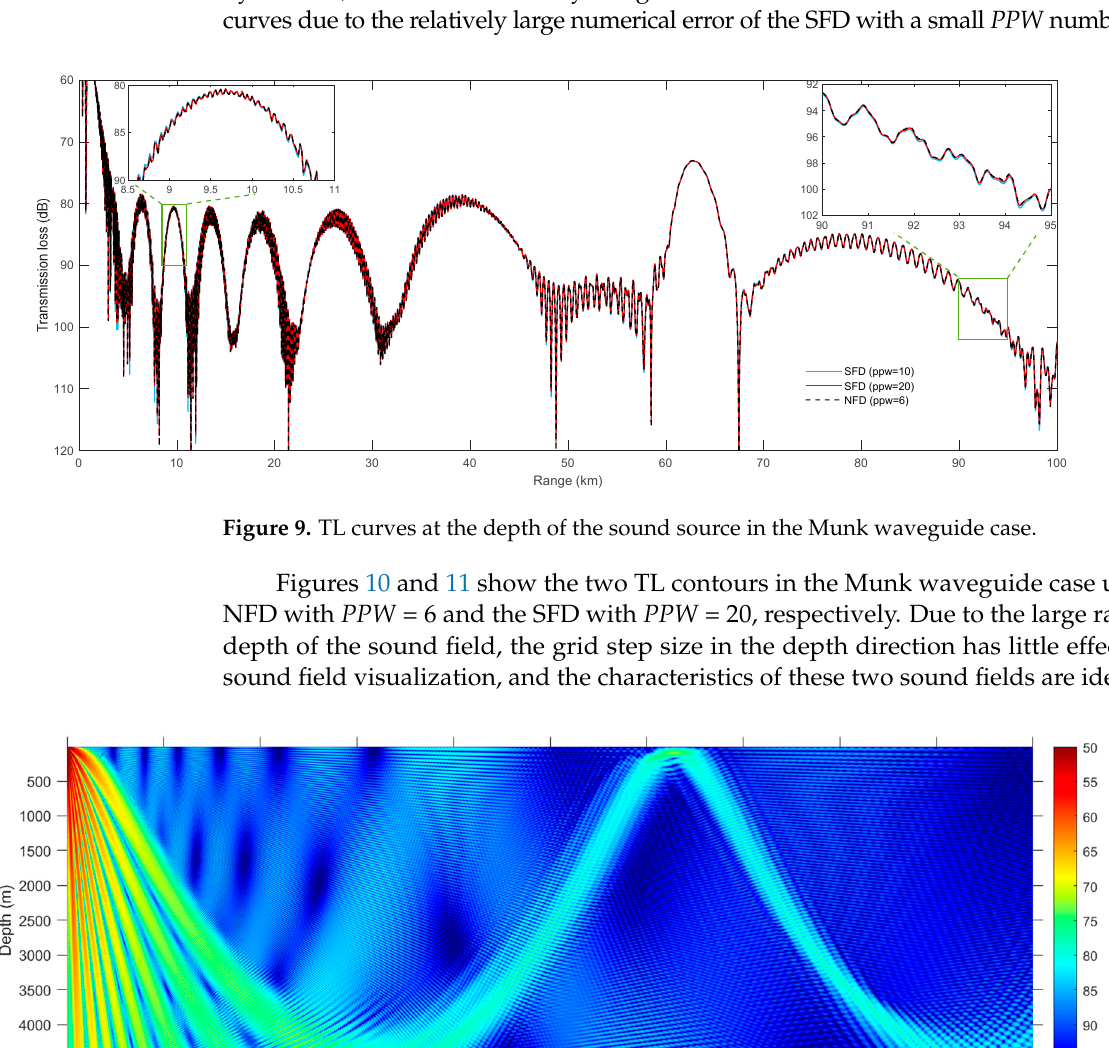
Figure 11. The TL contour in the Munk waveguide case using the SFD with PPW = 20. Furthermore, the computation time of KrakenC (mainly including the calculation of the eigenvalues and eigenfunctions, not including the calculation of the sound pressure field) can be significantly reduced using the NFD with smaller PPW numbers. In the Munk waveguide case, the computation time of KrakenC using the NFD with PPW = 6 and SFD with PPW = 10, 20 is 0.297 s, 0.375 s, and 0.703 s, respectively, meaning that the modified KrakenC using the NFD ( PPW = 6) runs more than twice as fast as the original KrakenC using the SFD ( PPW = 20) when their results have comparable accuracy. 4. Discussion The NFD for solving the modal equation in fluid media is presented in this paper, and three test cases are carried out to verify that the NFD is generally better than the SFD. The advantages of the NFD include that it can be used with a coarser grid in the depth direction to obtain results with the same accuracy as the SFD with a finer grid, meaning that the computation time and computational effort of the KrakenC model can be reduced accordingly. Moreover, the resulting system of linear equations still has the tridiagonal structure as that derived from the SFD. It should be noted that the proposed NFD in this paper is only applicable to horizontally stratified fluid media (not including elastic bound- ary conditions) where the sound speed of water changes slightly with depth. Although typical underwater environments meet this condition of weak vertical variation in sound speed, some particular environments may deviate from this condition, resulting in addi- tional numerical errors.